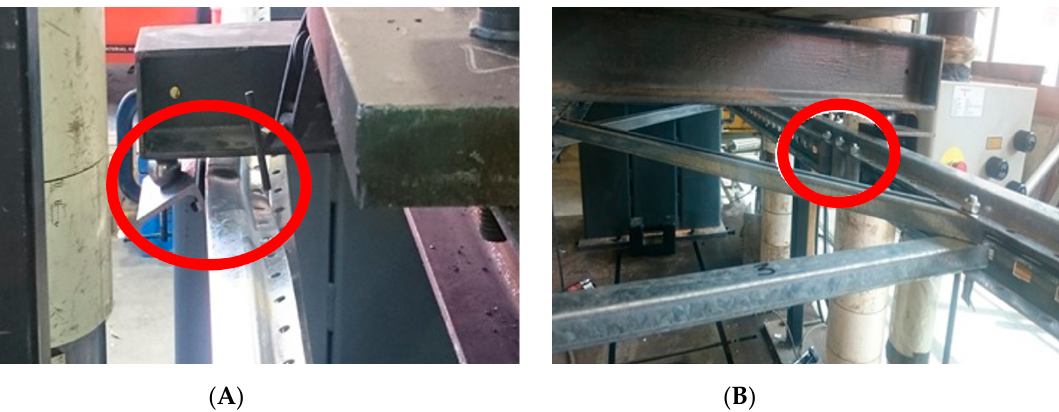
Figure 8. Crippling of load points: ( A ) Typical crippling at flanges; ( B ) Specific crippling reinforcement.